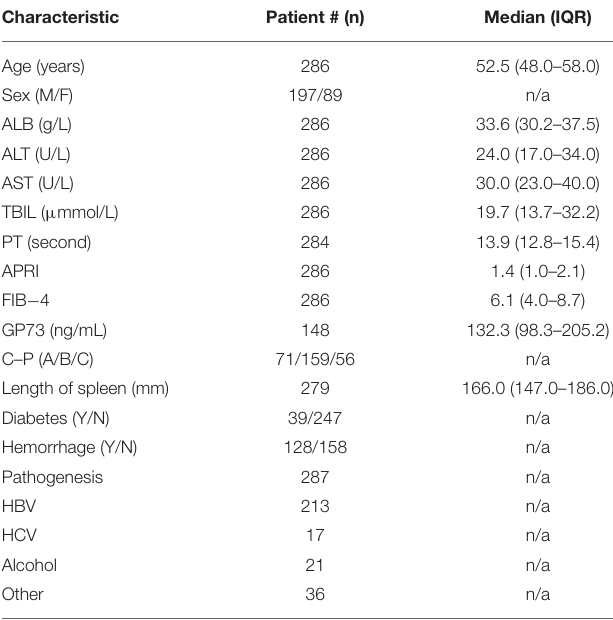
TABLE 1 | Baseline patient